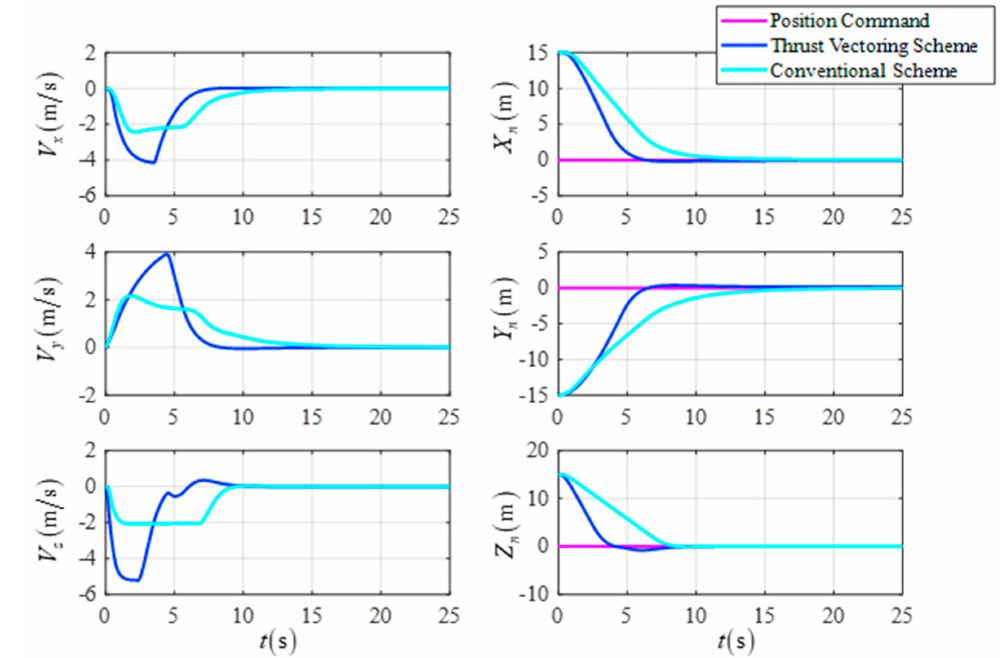
Figure 15. The position and the velocity in